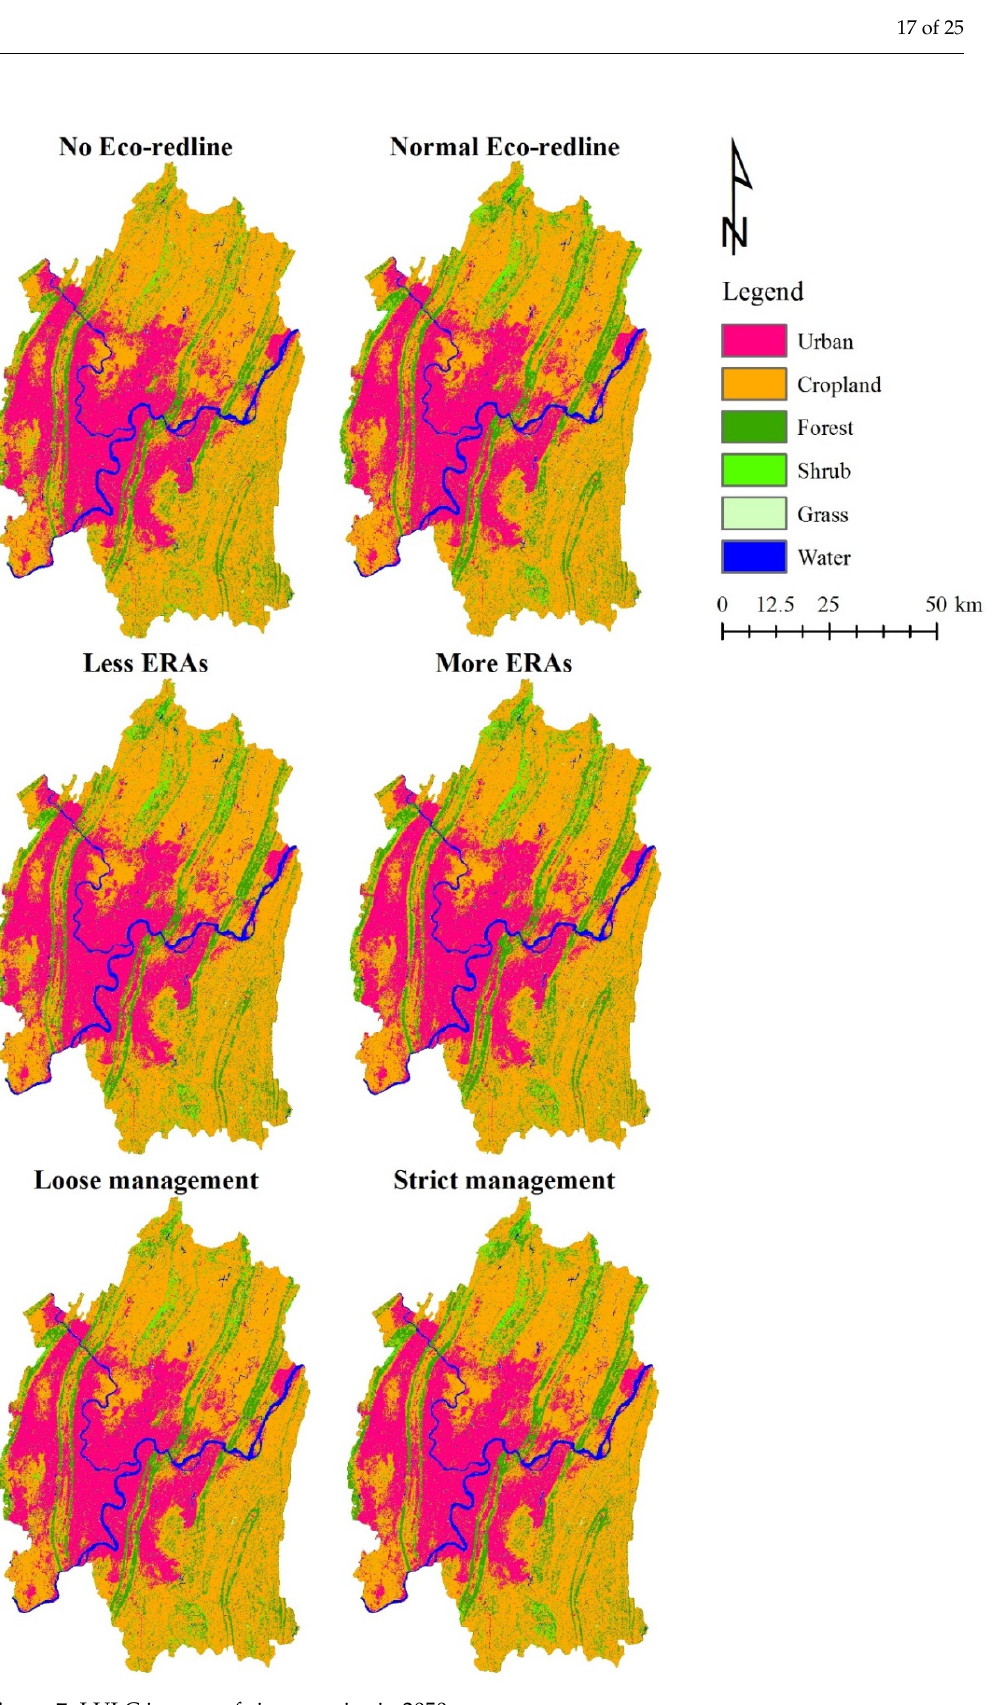
Figure 7. LULC images of six scenarios in 2050.